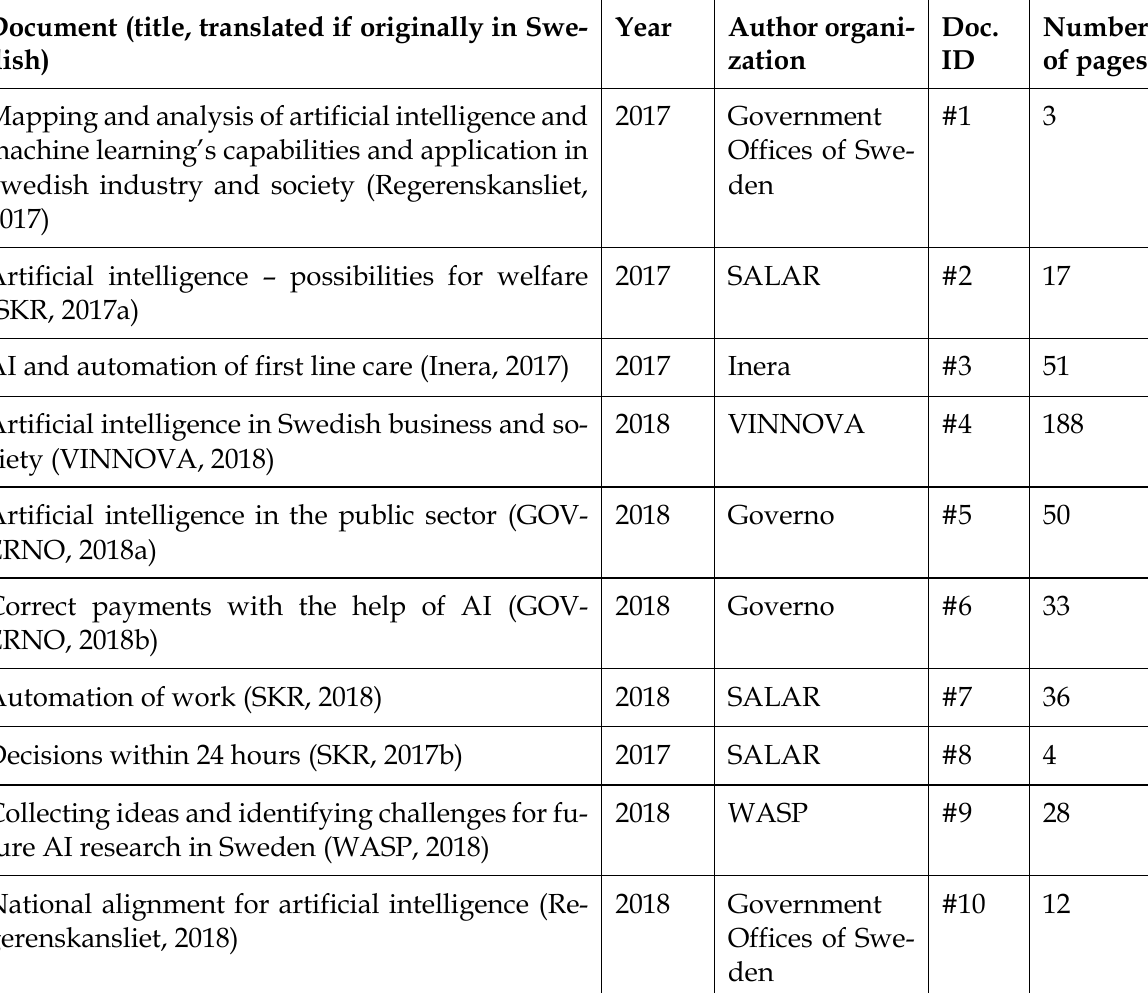
Table 2. The policy documents used for our analysis (Toll et al., 2019).